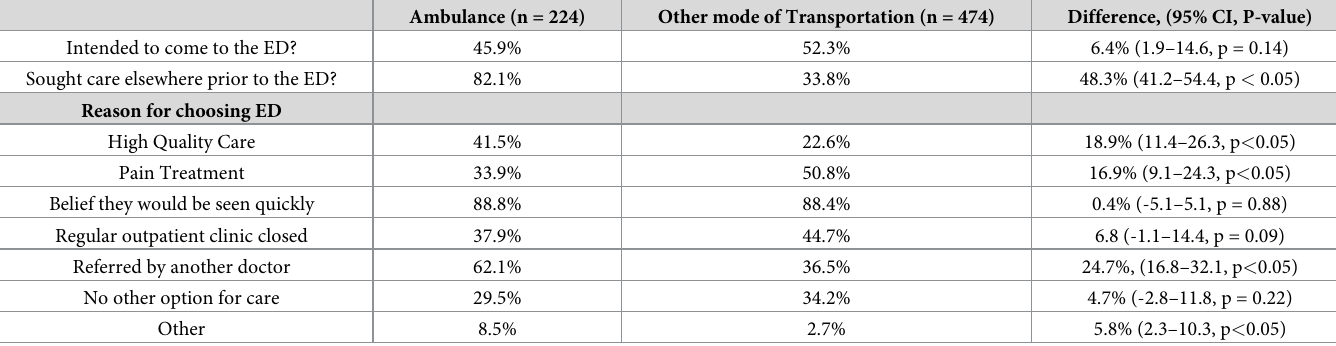
Table 10. Ambulance vs other mode of